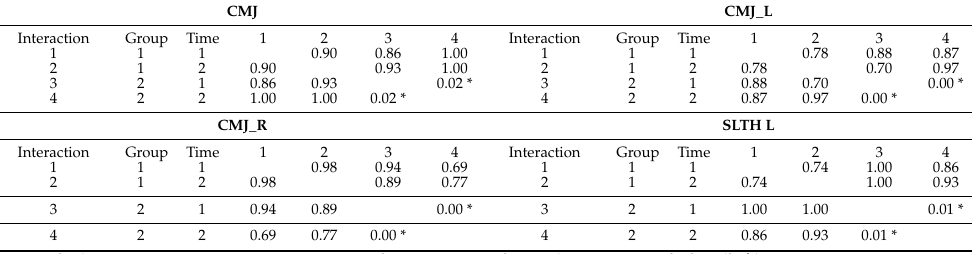
Table 3. Tukey’s post hoc results for variables with significant